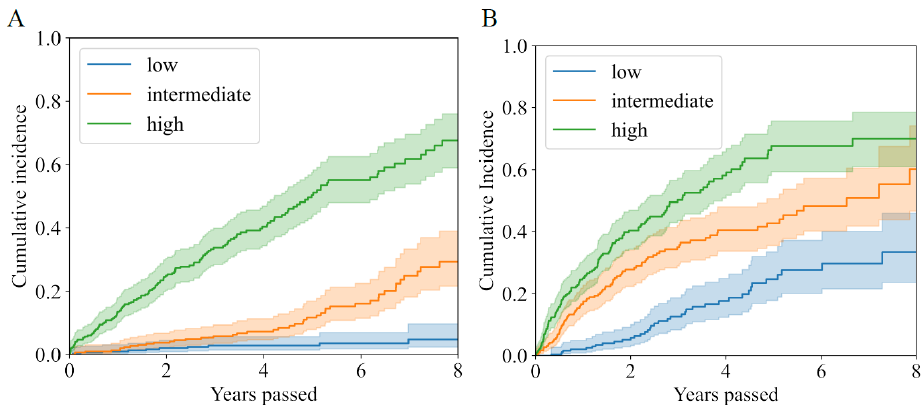
Figure 5. Cumulative incidence curves of all-cause death ( A ) and first appropriate shock ( B ) by risk stratum.